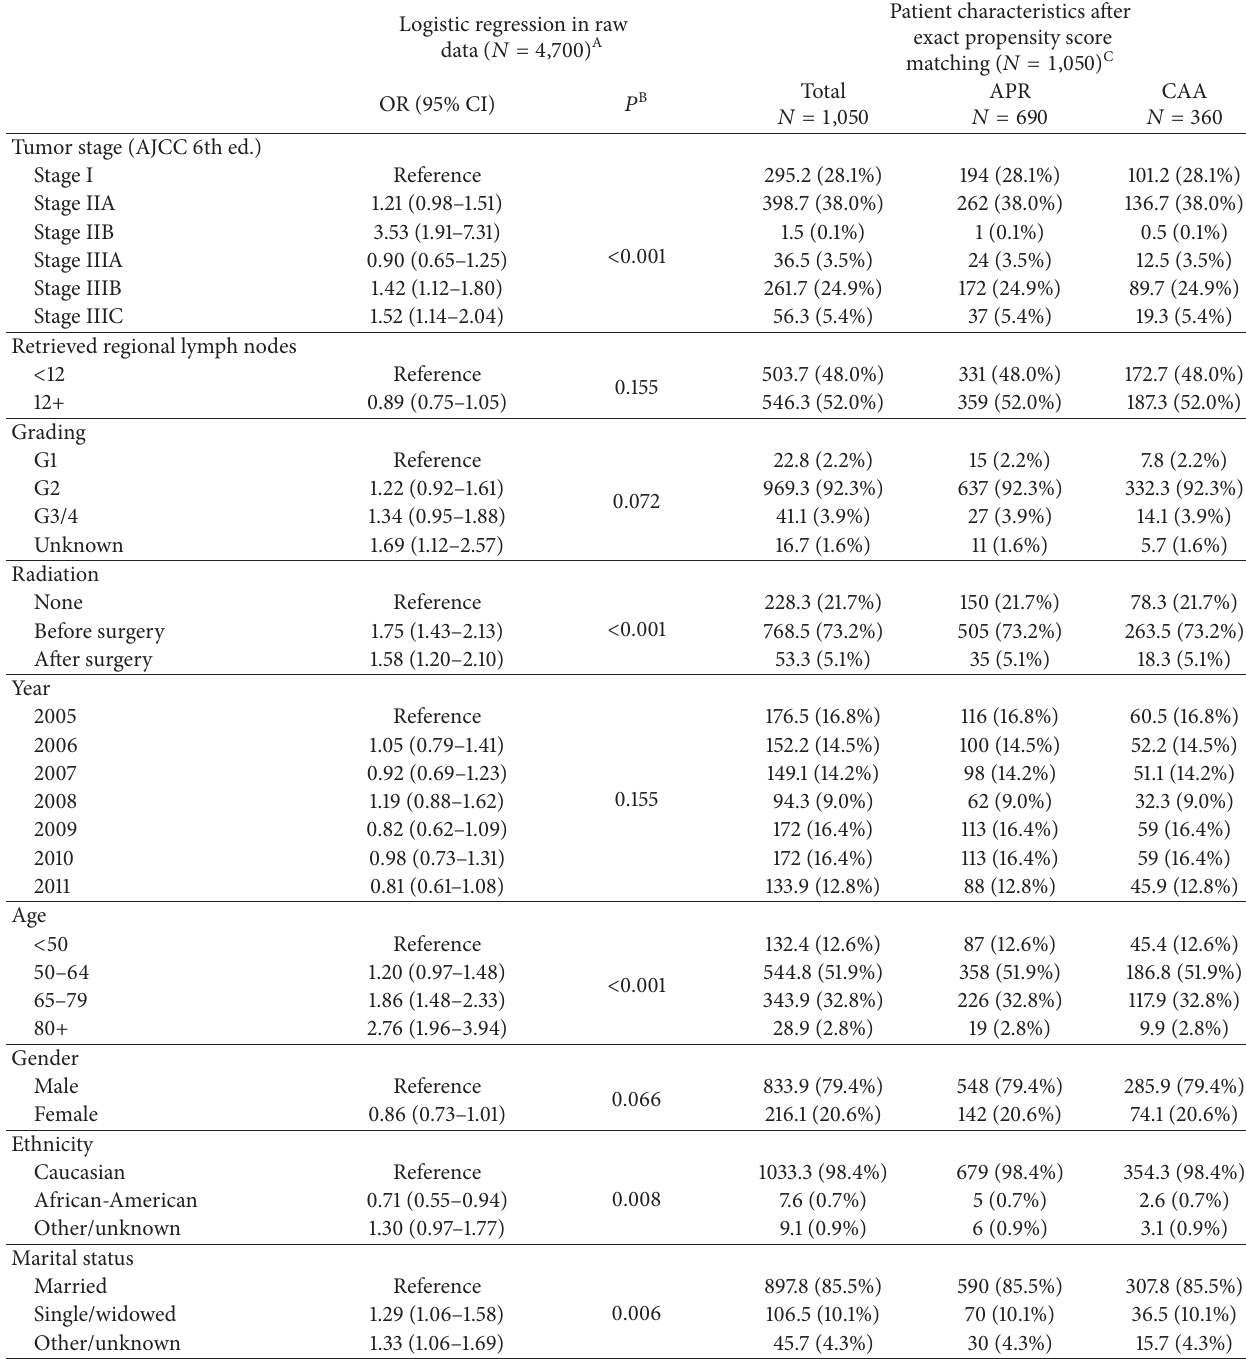
Table 3: Bias for abdominoperineal resection.